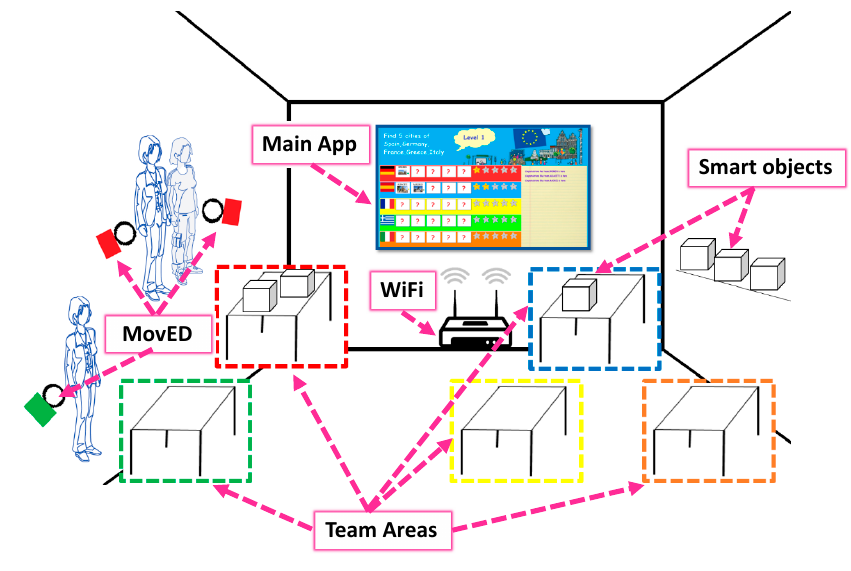
Figure 1. Classroom organization.